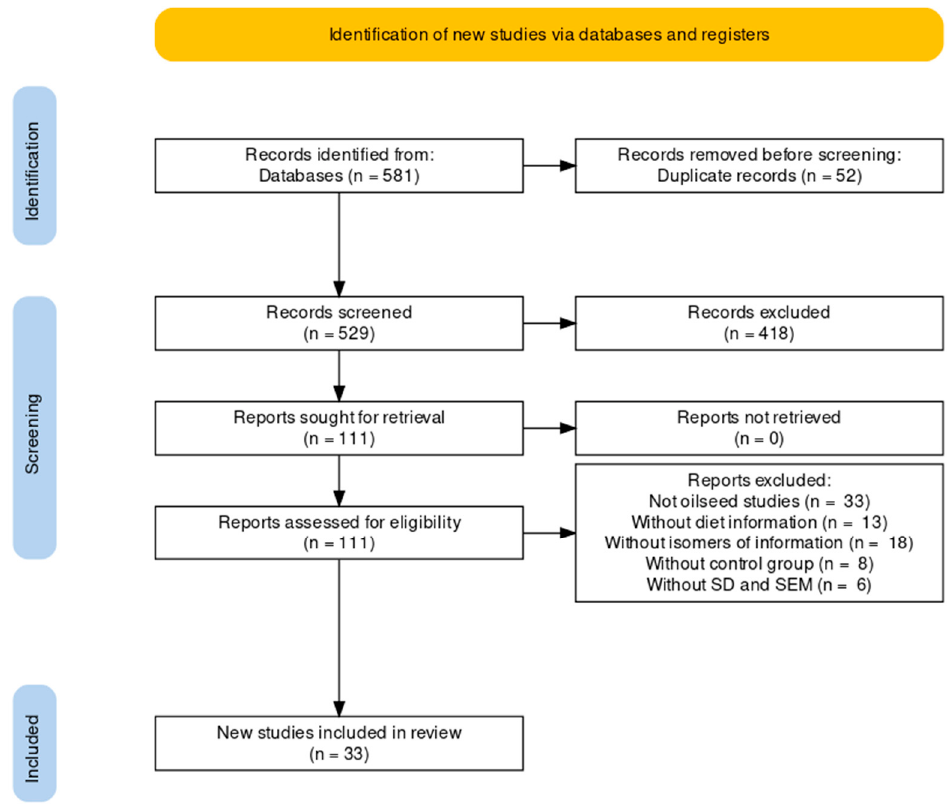
Figure 1. Flowchart of the systematic review (PRISMA) from the initial search to the selection of the articles included in this review.